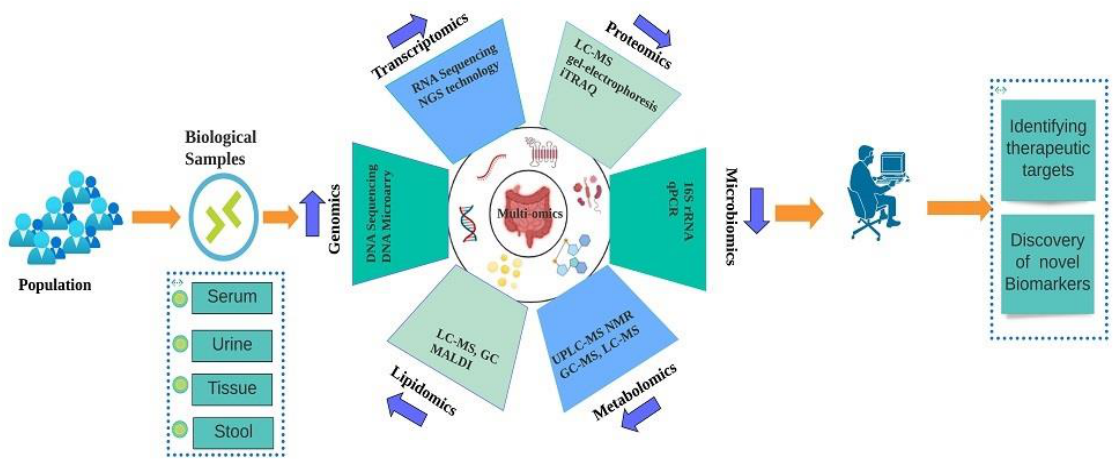
Figure 1. Graphical representation of different multi-omics-based approaches in discovering novel CRC biomarkers and therapeutic targets.